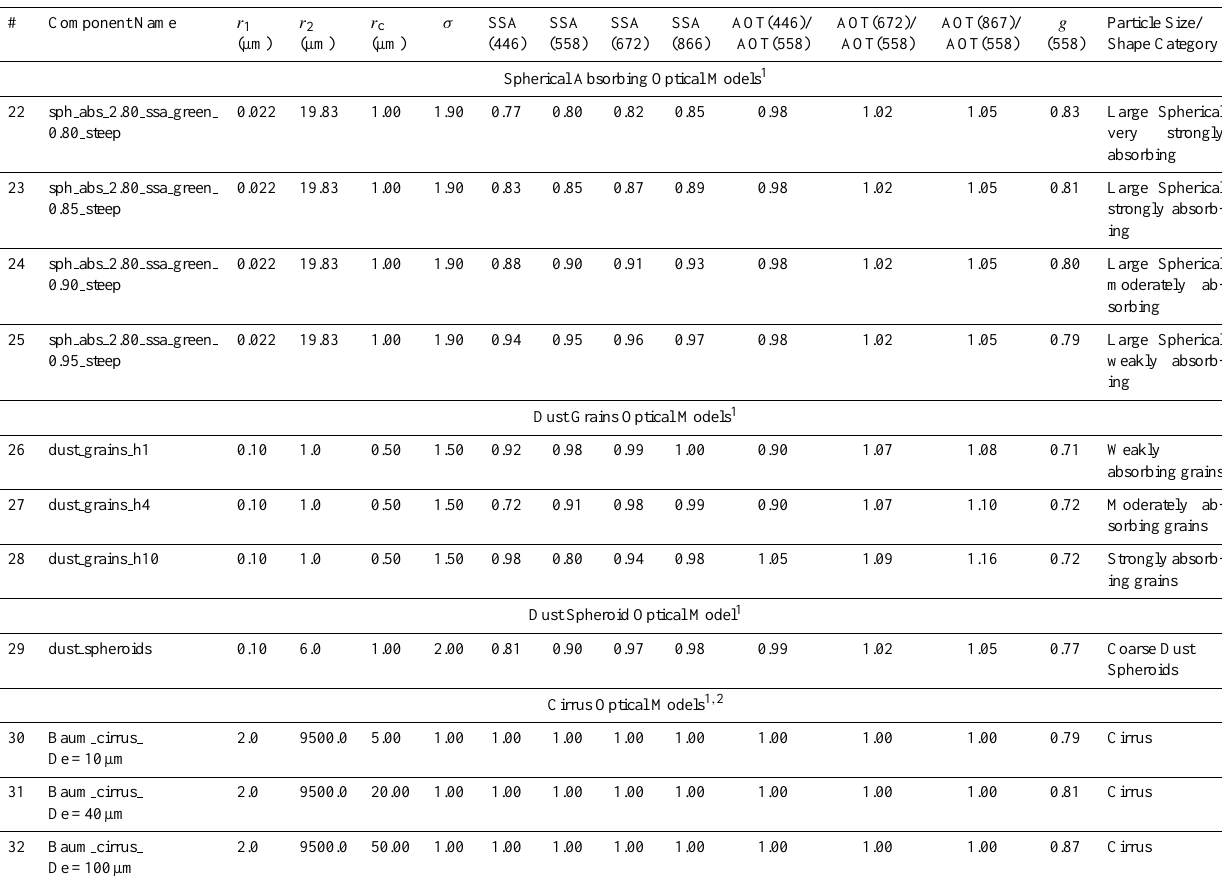
1 Aerosol components are named based on particle shape (spherical, non-spherical grains, spheroids, or cirrus), SSA (non-absorbing, weakly, moderately, strongly, or very strongly absorbing) and effective radius (in micrometers). Single scattering properties were calculated using a Mie code for the spherical particles; the dust component properties were calculated using the Discrete Dipole and T-matrix approaches for medium and coarse modes, respectively (Kalashnikova et al., 2005). Wavelength in nm is specified in parentheses where appropriate. r 1 and r 2 are the upper and lower limits of the size distribution, r c and σ are the characteristic radius and width parameters in the log-normal distribution, and SSA is the single-scattering albedo. The asymmetry parameter ( g ) will generally represent particle scattering phase functions poorly for the purpose of calculating MISR multi-angle radiances, and is given here only in MISR green band for reference. The vertical distributions of particles are based on plume height; aerosol is concentrated near-surface for control regions. 2 Gamma distribution is used for cirrus particle models, and r c is replaced by r e , the effective radius (Baum et al.,